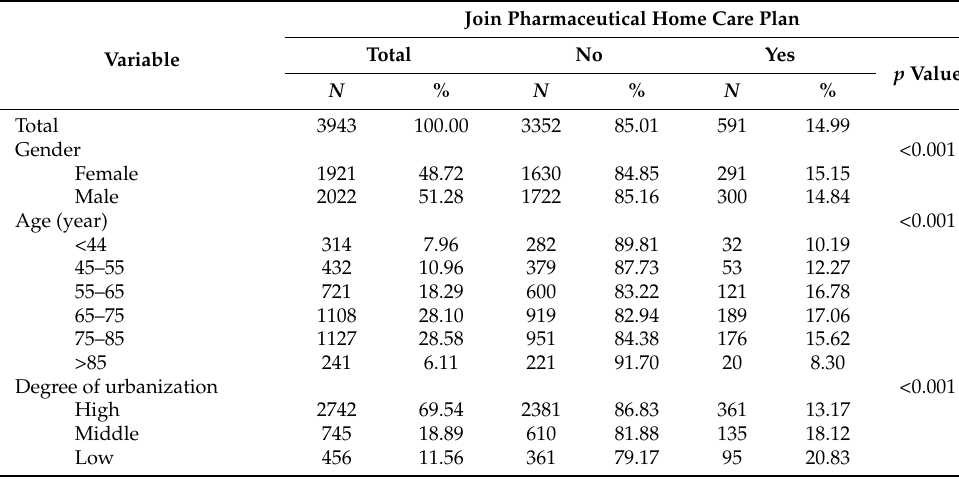
Table 1. The baseline characteristics of patients with a high frequency of visits.